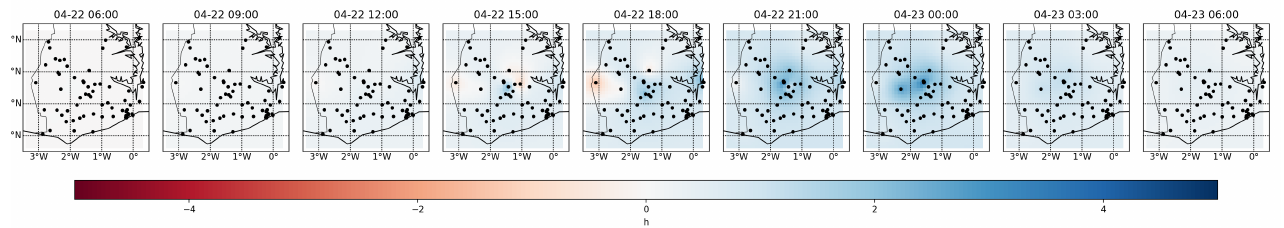
Figure 14. Mean of the mappings in the LOOV experiment. The positions of the stations are marked by black dots.